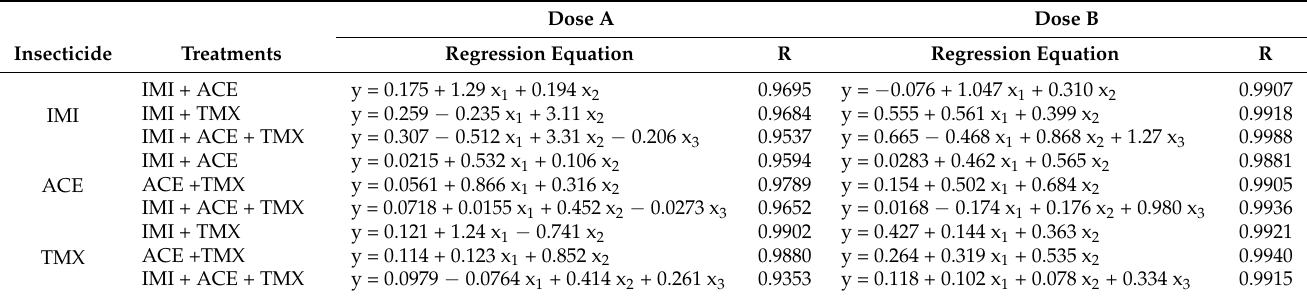
Table 2. Regression analysis of neonicotinoid mixtures’ residues in Brassica chinensis L. Dose A Dose B Insecticide Treatments Regression